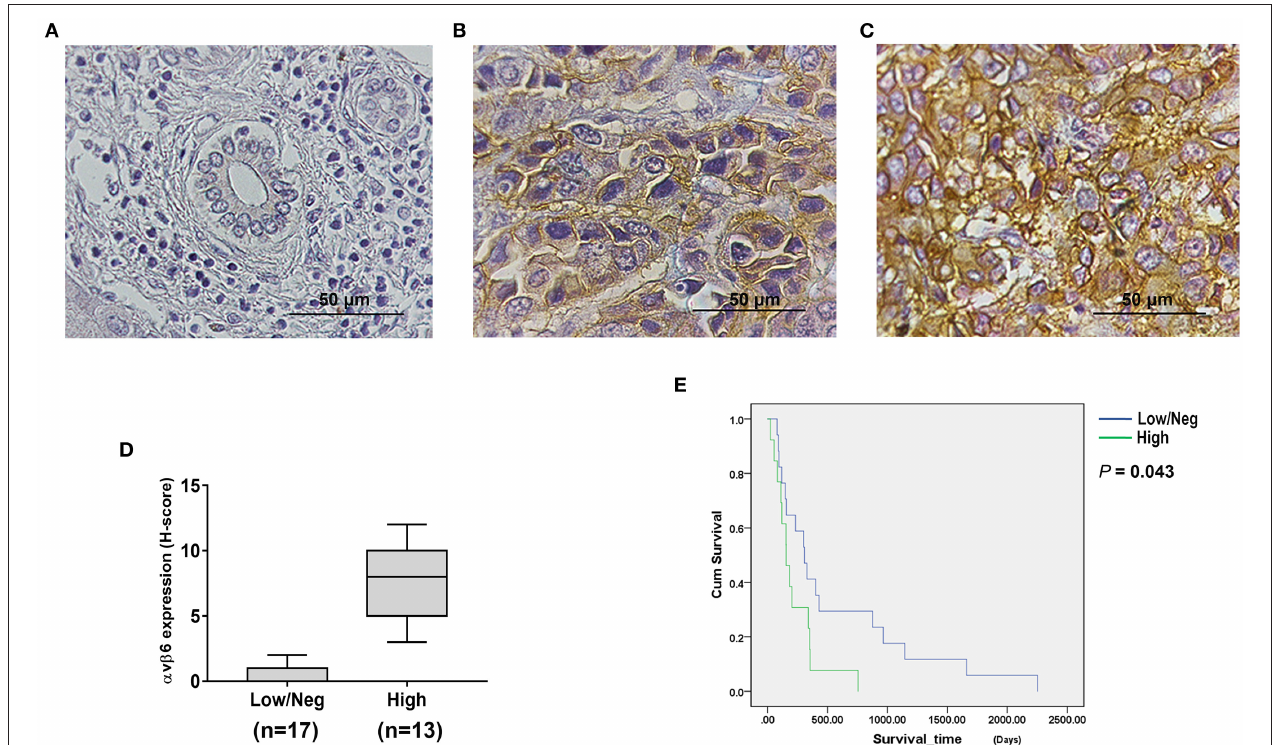
FIGURE 1 | Integrin α v β 6 was upregulated in cholangiocarcinoma (CCA) tissues. Immunohistochemical (IHC) staining was performed to examine integrin α v β 6 expression in CCA tissues obtained from liver fluke-associated CCA patients. (A) Negative staining of normal bile duct epithelial cells and hepatocytes surrounding the tumor area was observed. Positive staining of the integrin α v β 6 protein was detected in the cytoplasm and membrane of tumor cells with (B) low and (C) high expression levels. Scale bars represent 50 µ m. (D) Expression levels of integrin α v β 6 in CCA tissues were summarized as H-scores. (E) Cumulative overall survival curves of CCA patients with different expression levels of integrin α v β 6. The cumulative survival time of patients who had high expression levels of integrin α v β 6 was significantly shorter than that of the patients who had low/negative expression levels of integrin α v β 6 ( p = 0.043).